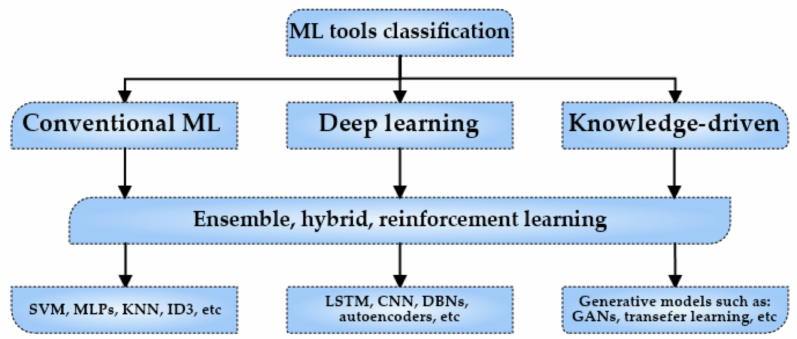
Figure 10. Classification of ML